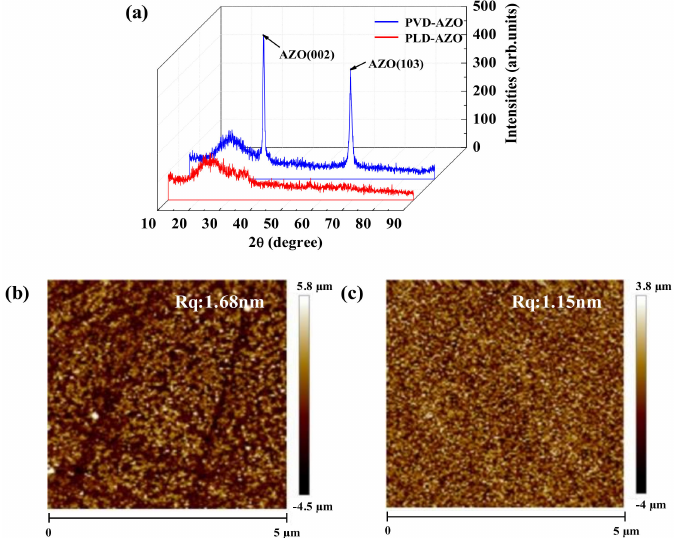
Figure 2. ( a ) XRD spectra of PVD-AZO and PLD-AZO; the surface topography of ( b ) PVD-AZO and ( c )